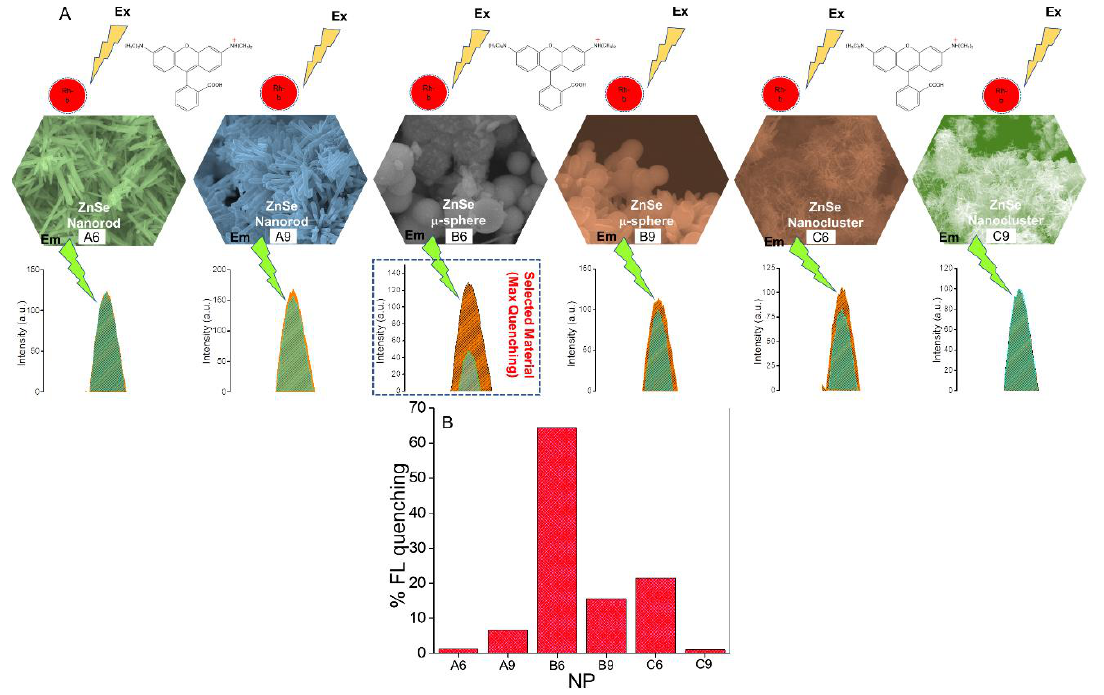
Figure 4. Summary of fluorescence quenching behavior of ZnSe nanostructures (A6 – C9) (450 µg/L) based on structural morphology and negative surface charge (Rh-B: 160 ng/L) ( A ). % fluorescence quenching effect of ZnSe (A6, A9, B6, B9, C6, C9) ( B ).